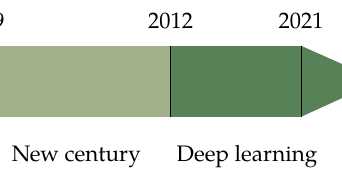
Figure 1. Colour texture descriptors: proposed taxonomy.